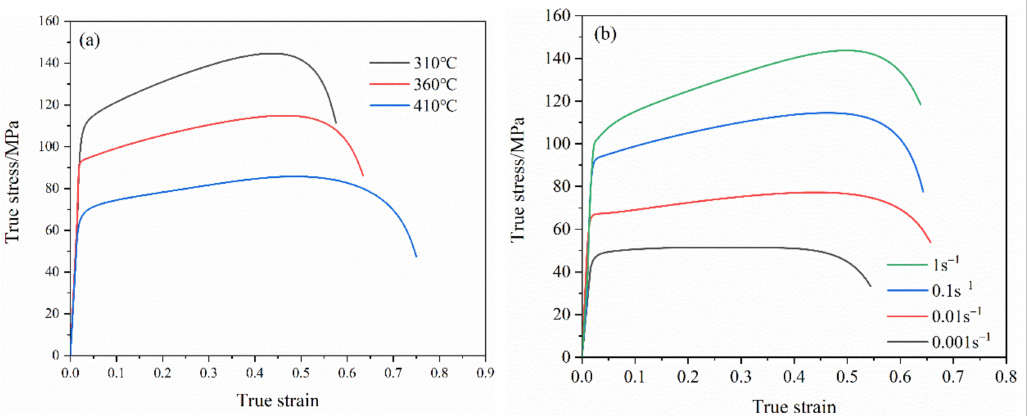
Figure 4. The stress-strain curve of 7075 aluminum alloy under different conditions. ( a ) The strain rate is 0.1, ( b ) the deformation temperature is 360 ◦